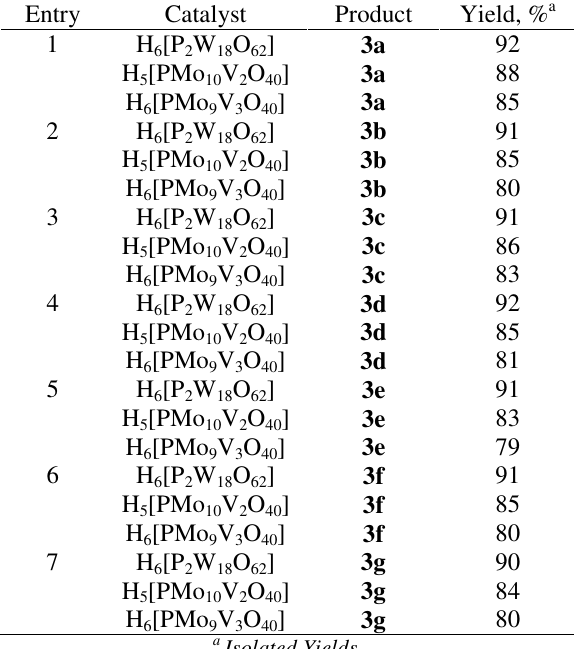
Table 2 . Synthesis of Quionlines using various heteropoly acids under solvent-free condition. Entry Catalyst Product Yield, %